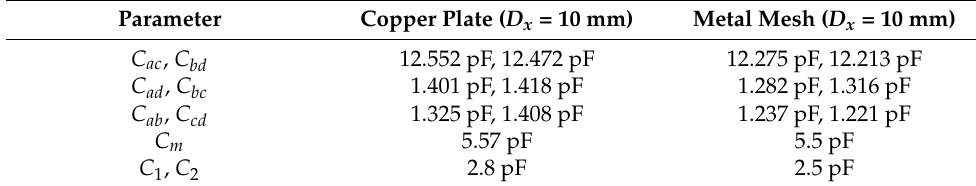
Figure 5. Practical equivalent circuit model. Table 1. RLC Meter Measured Capacitance Components.